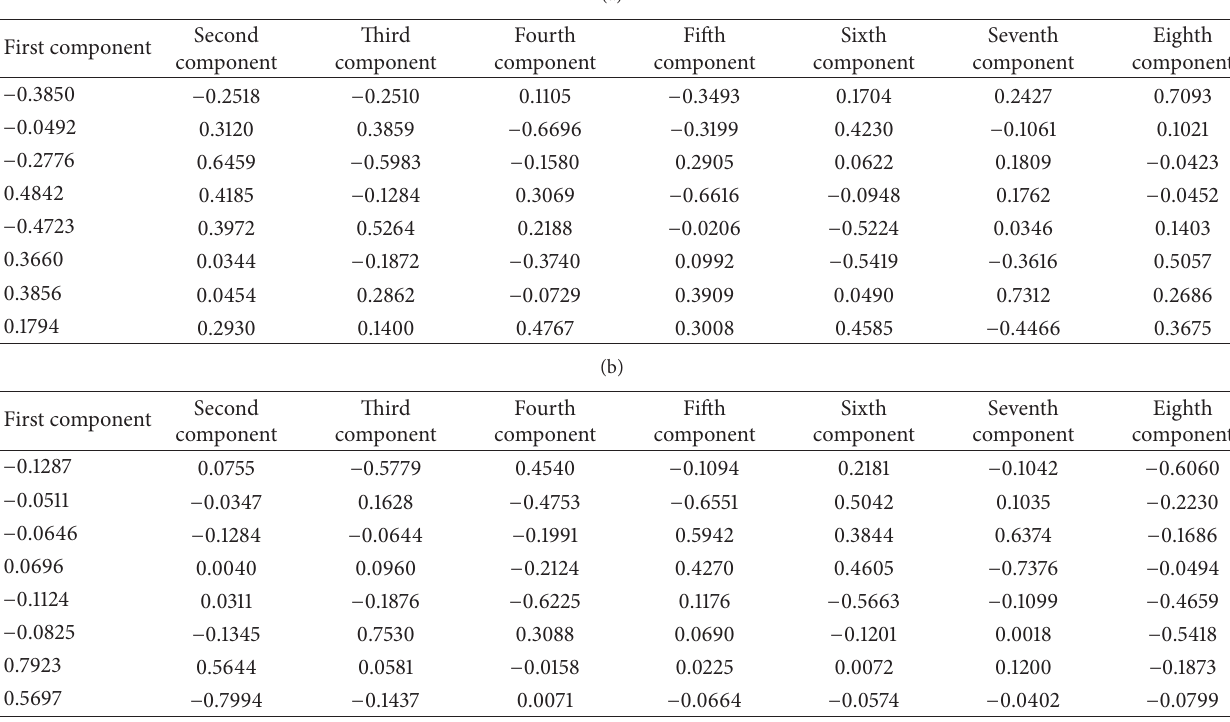
Table 7: Feature vector matrix in GTOC1.